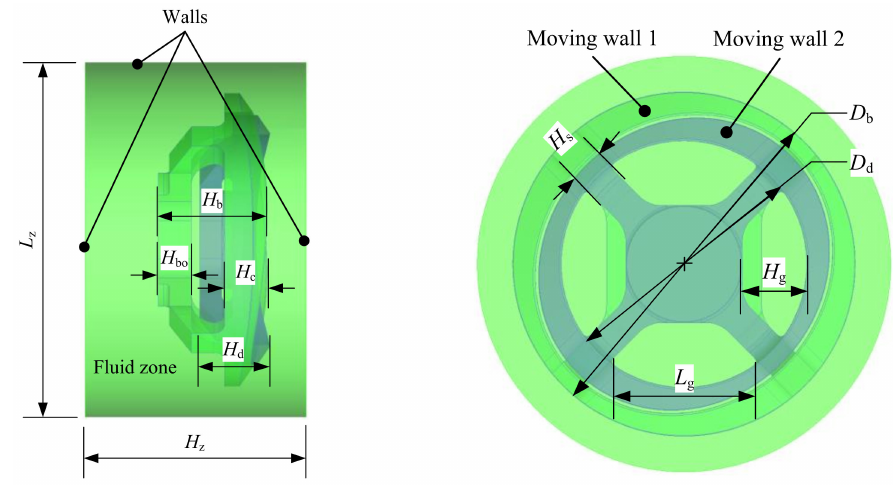
Figure 5. Schematic representation of the rotor in the fluid zone. Table 1. Parameters of the fluid